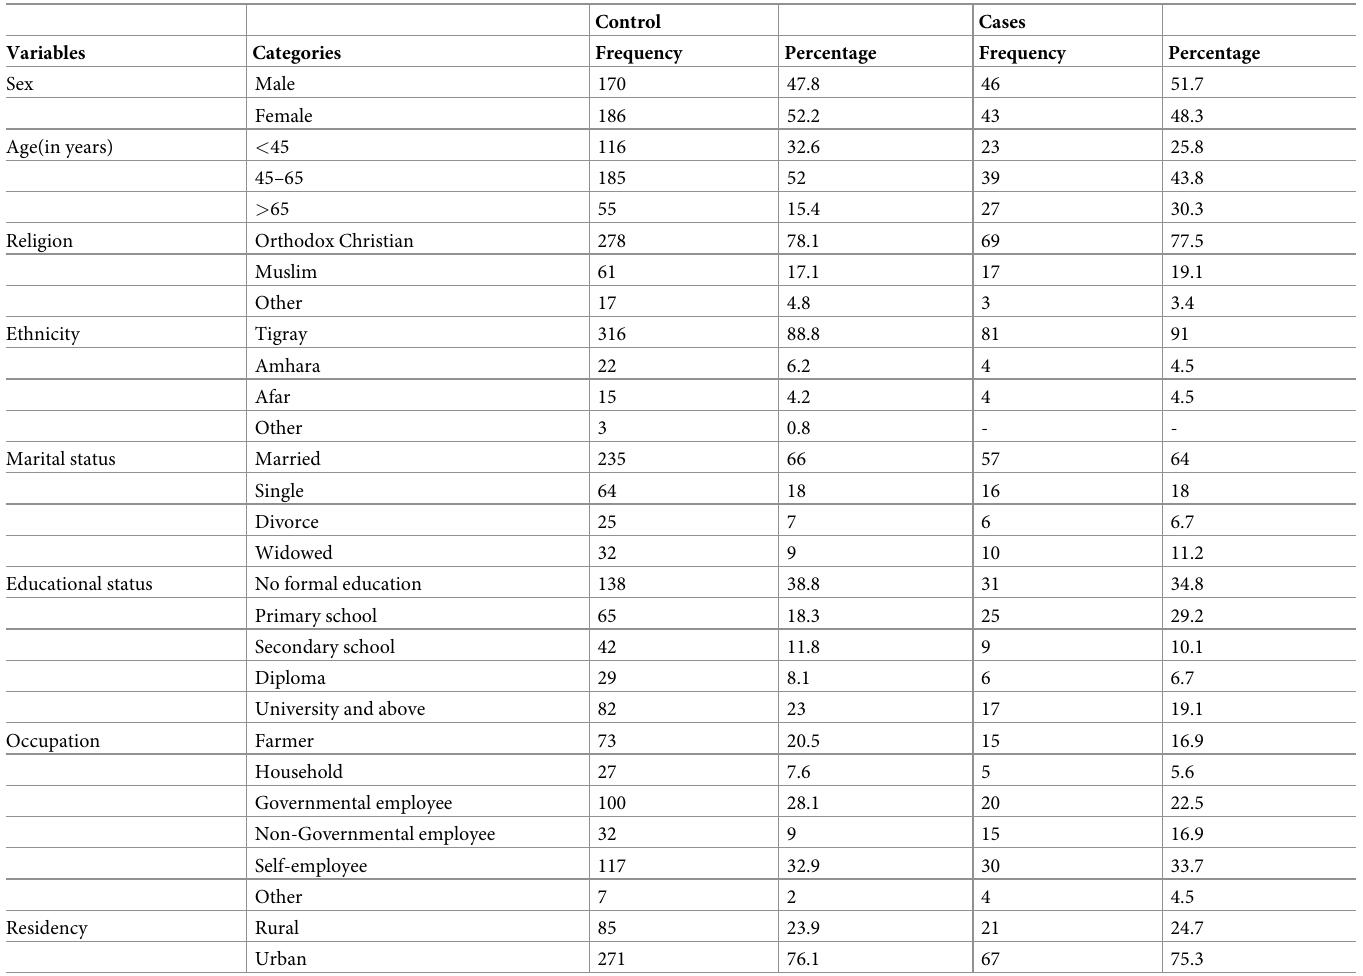
Table 1. Socio demographic characteristics of the study participants.